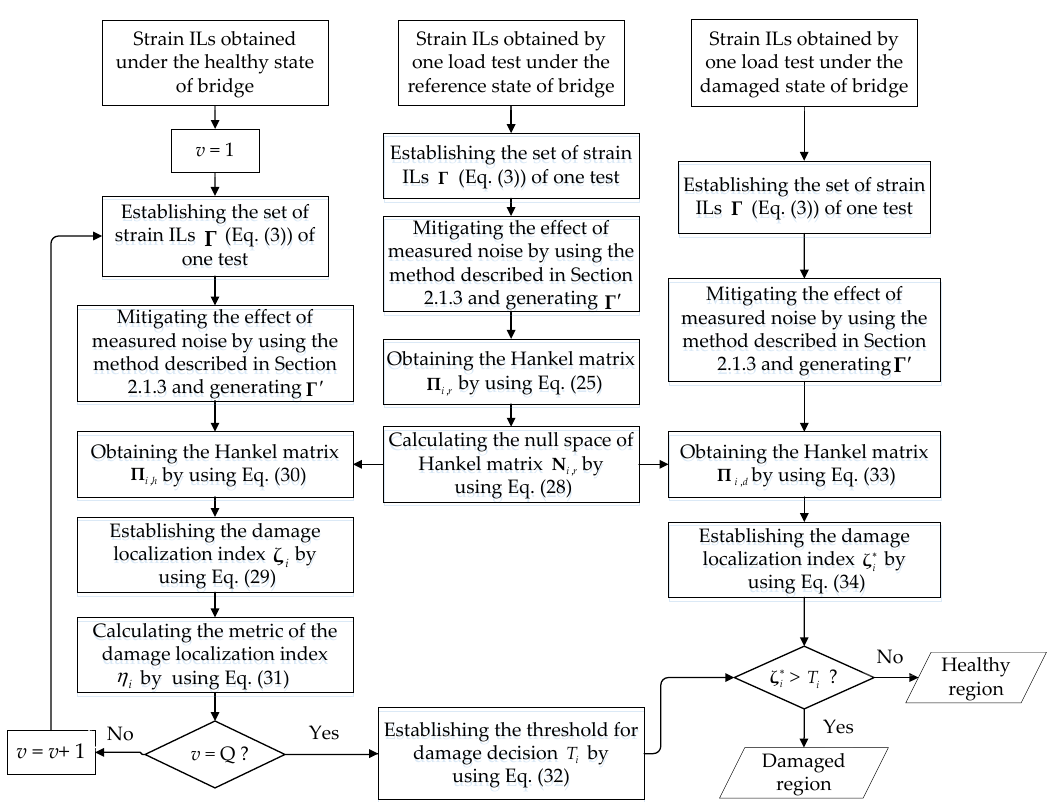
Figure 2. Diagram of the damage localization method (for the strain IL at the i th measured point).